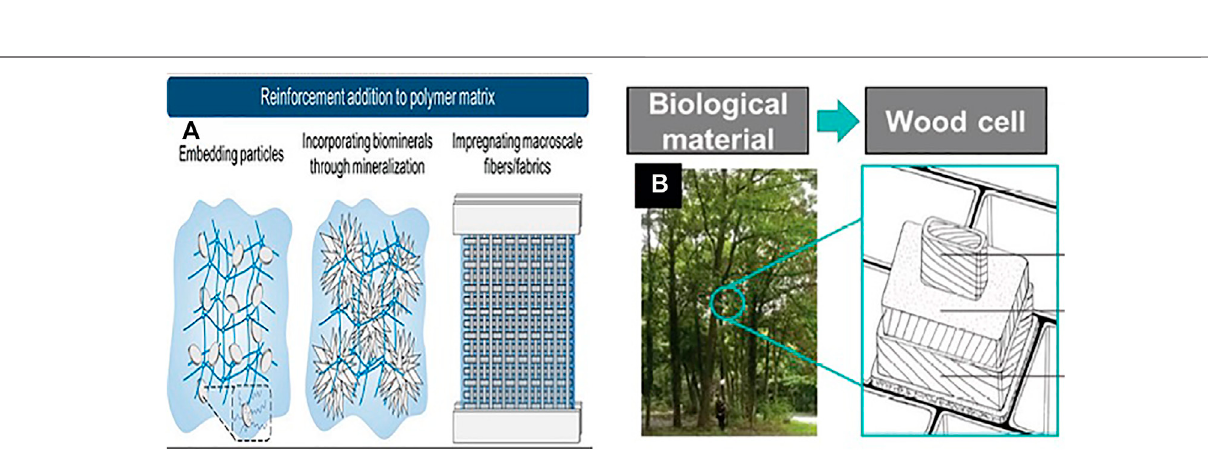
FIGURE 5 | Physio-mechanicalproperties of biological tissues vital to mimic in compositesstructure: (A) J-shaped mechanical behavior, (B) mechanism to realize anisotropy via J-shaped stress − strain behavior (Ma et al., 2017) Copyright © 2020, American Chemical Society.